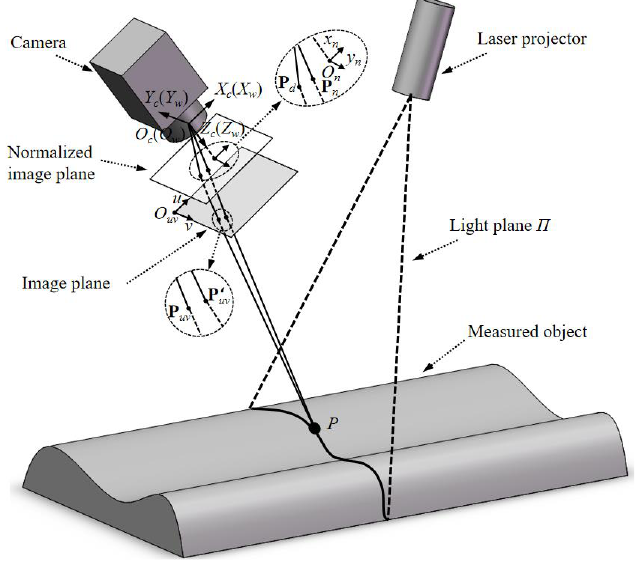
Figure 1. Schematic diagram of the line-structured light 3D measurement process.